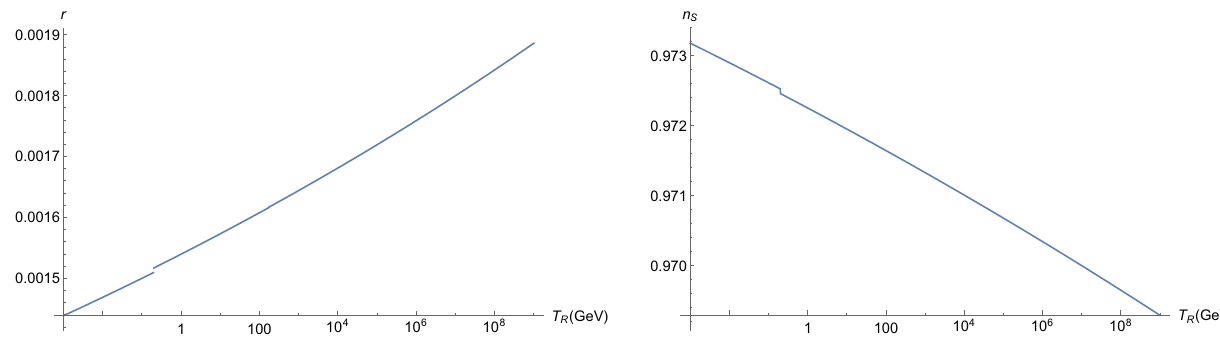
Fig. 5 Evolution of the tensor/scalar ratio r (left) and the spectral index n s (right) versus the reheating temperature T R √ √ ∼ = that ˙ ϕ E = 6 H E M pl 6 H end M pl =